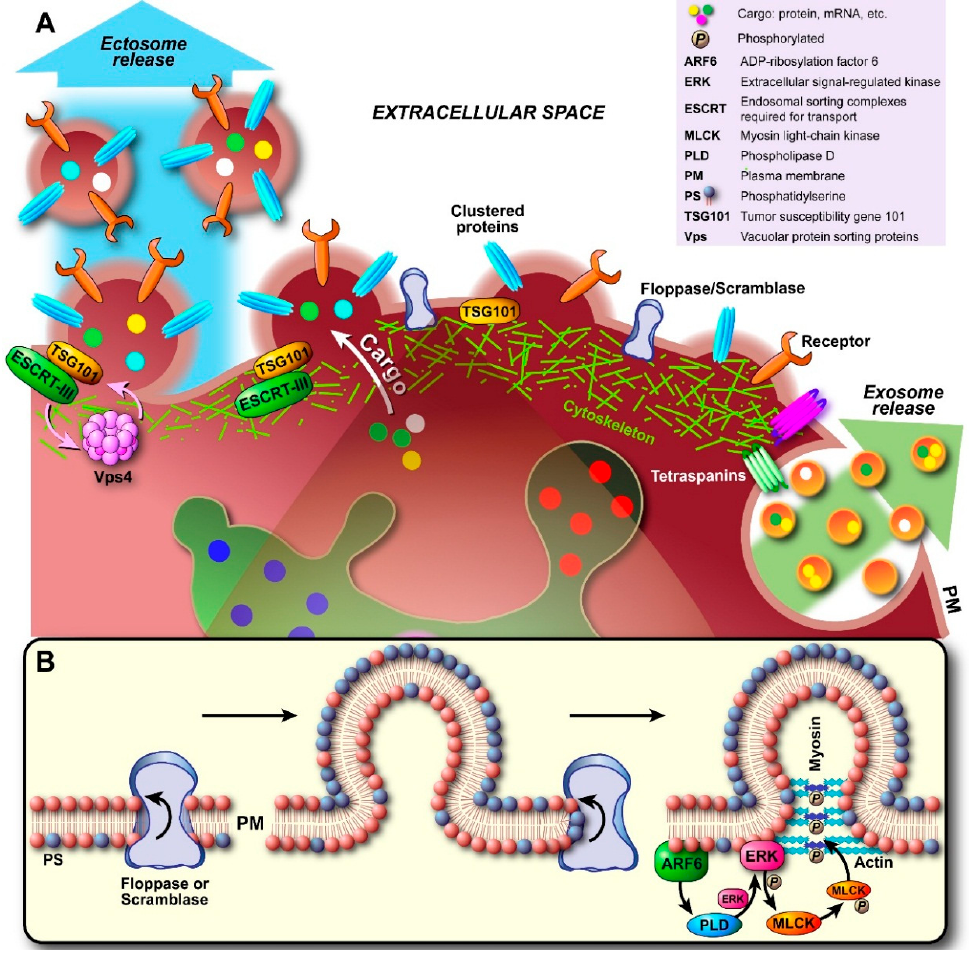
Figure 4. Biogenesis and secretion of ectosomes. ( A ) Initial nucleation at the plasma membrane (PM) starts with clustering of transmembrane proteins and lipids in distinct domains. Recruited and PM associated proteins such as tetraspanins (largely still unidentified) may be involved in sorting of components analogous to exosomal sorting. Additionally, Ca 2+ release/accumulation and activation of enzymes induce degradation of cytoskeletal components. Outward budding is promoted by externalization of phosphatidylserine (PS) by specific translocases (floppase, scramblase; see also ( B )). As the cytoskeleton disintegrates locally and becomes more traversable, cytosolic proteins and genetic material are sorted into the lumen. Budding and pinching off are generally thought to occur either through the model proposed in ( B ), where budding involves initiation of a signaling cascade by ARF6 through activation and recruitment of PLD/ERK and phosphorylation of MLCK. This triggers actomyosin contraction and pinching off of the ectosome. Alternatively, recent evidence suggests that recruited TSG101 induces translocation of ESCRT-III to the PM, which in turn results in conical spiral assembly (budding initiator), and finally Vps4 ATPase constriction of the ring of ESCRT-III spirals at the budding neck leads to membrane scission and pinching off, as shown in ( A ).